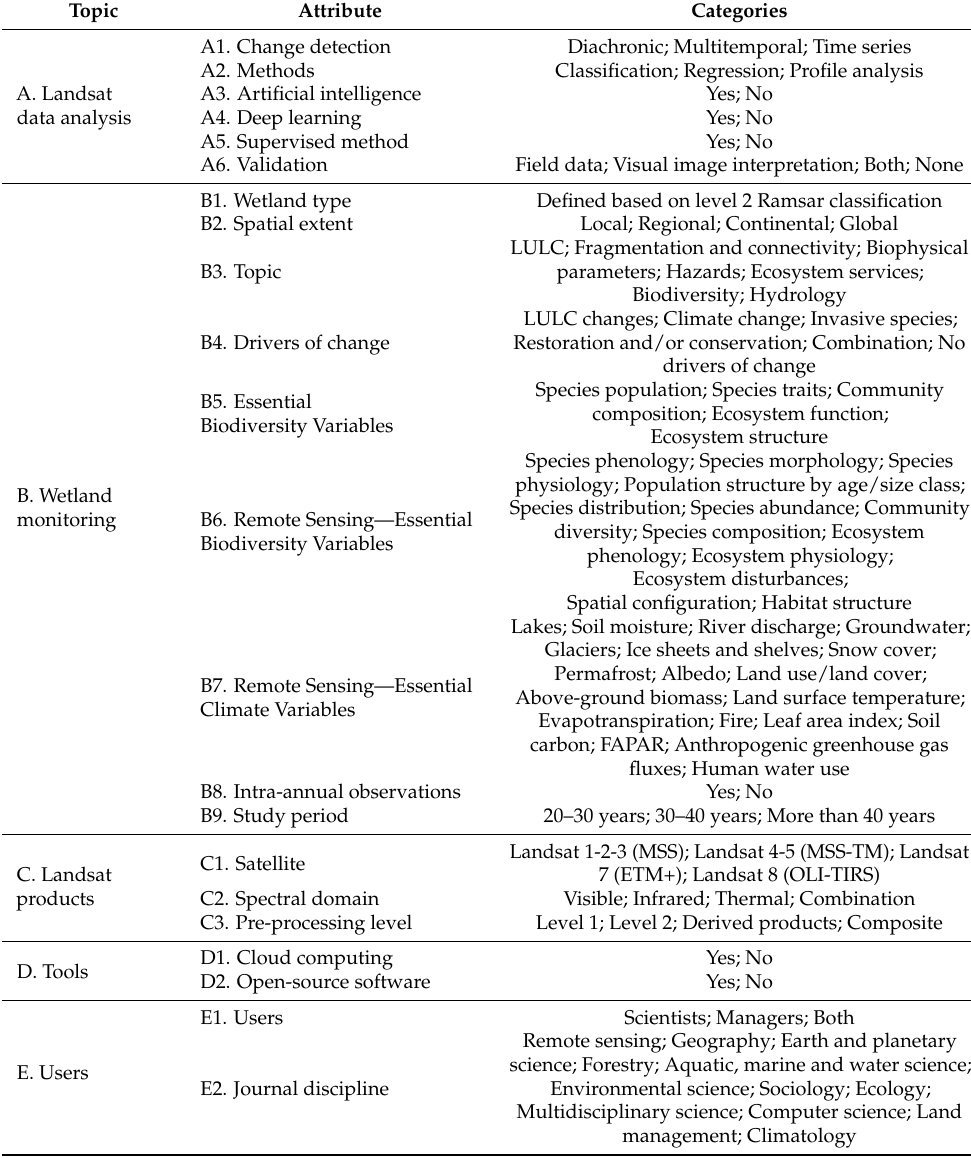
Table 1. Topics, attributes, and categories used in the literature review (see Supplementary Materials Table S3 for a full description of categories). LULC: land use/land cover change; FAPAR: fraction of absorbed photosynthetically active